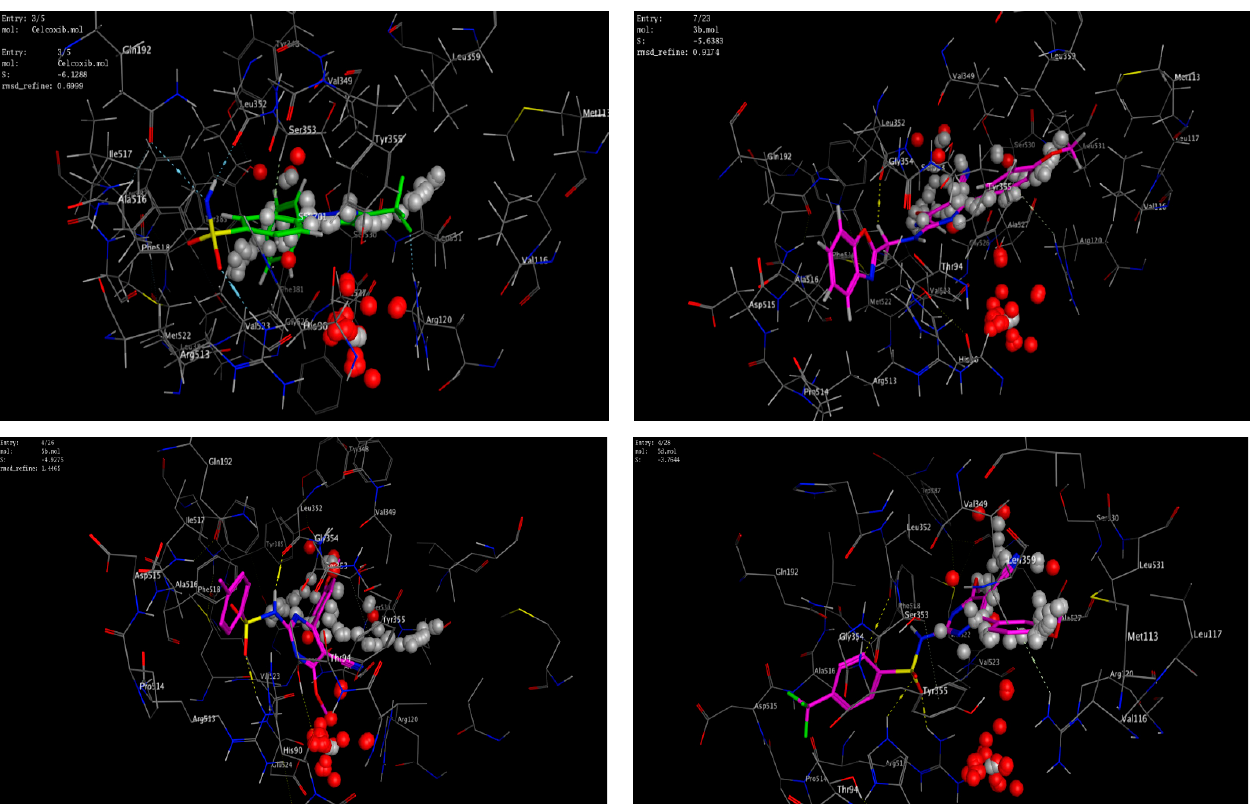
Figure 6. 2D interactions of the co-crystallized ligand Celecoxib (upper left panel), 3b (upper right panel), 5b (lower left panel), and 5d (lower right panel) with the active site of cyclooxygenase 2 (PDB ID code: 1CX2).